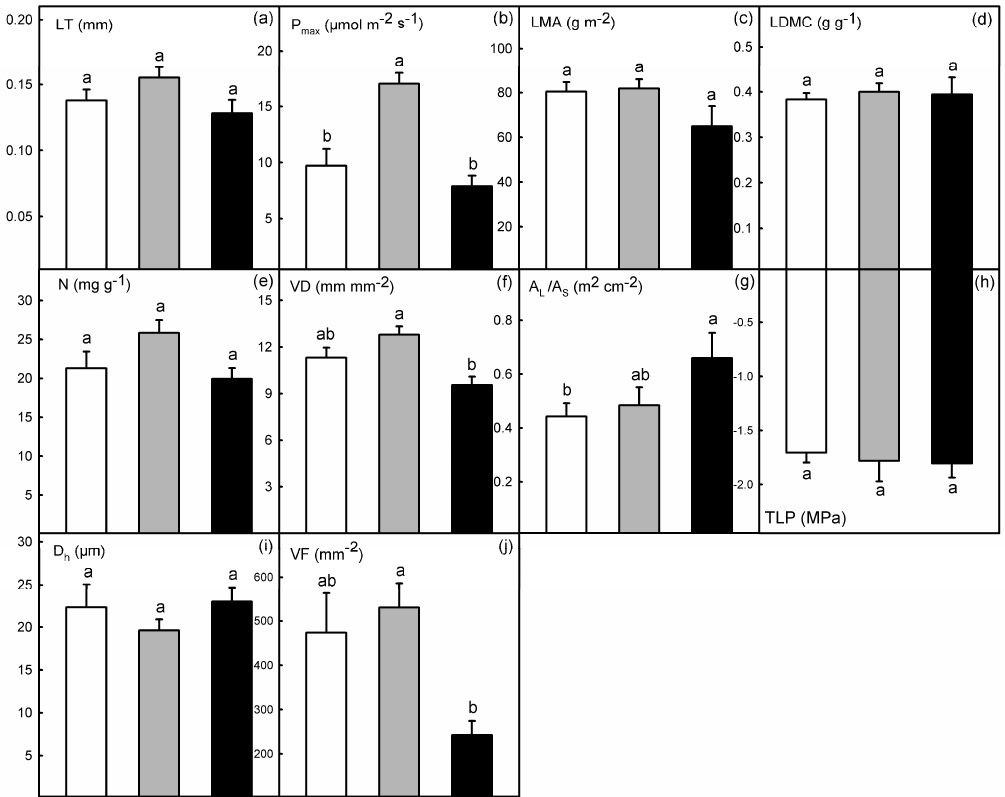
Figure 1. Di ff erences in ( a–e ) economic traits and ( f–j ) hydraulic traits of woody plants among the shrub stage (white columns), pioneer tree stage (grey columns) and late successional stage (black columns). Error bars represent 1 SE and di ff erent letters denote significant di ff erences among di ff erent stages ( P < 0.05, ANOVA). Trait abbreviations: LT (leaf thickness), P max (maximum net photosynthesis rate), LDMC (leaf dry matter content), LMA (leaf dry mass per area), N (leaf nitrogen concentration per mass), VD (vein density), TLP (leaf water potential at turgor loss point), A L / A S (leaf area to sapwood area ratio), VF (vessel frequency), and D h (hydraulically weighted diameter). Table 2. Pearson correlation coe ffi cients (lower diagonal) and phylogenetically independent contrasts (upper diagonal) among 10 leaf traits. Pearson correlation analysis indicated that VD was positively related to P max , LMA and LT